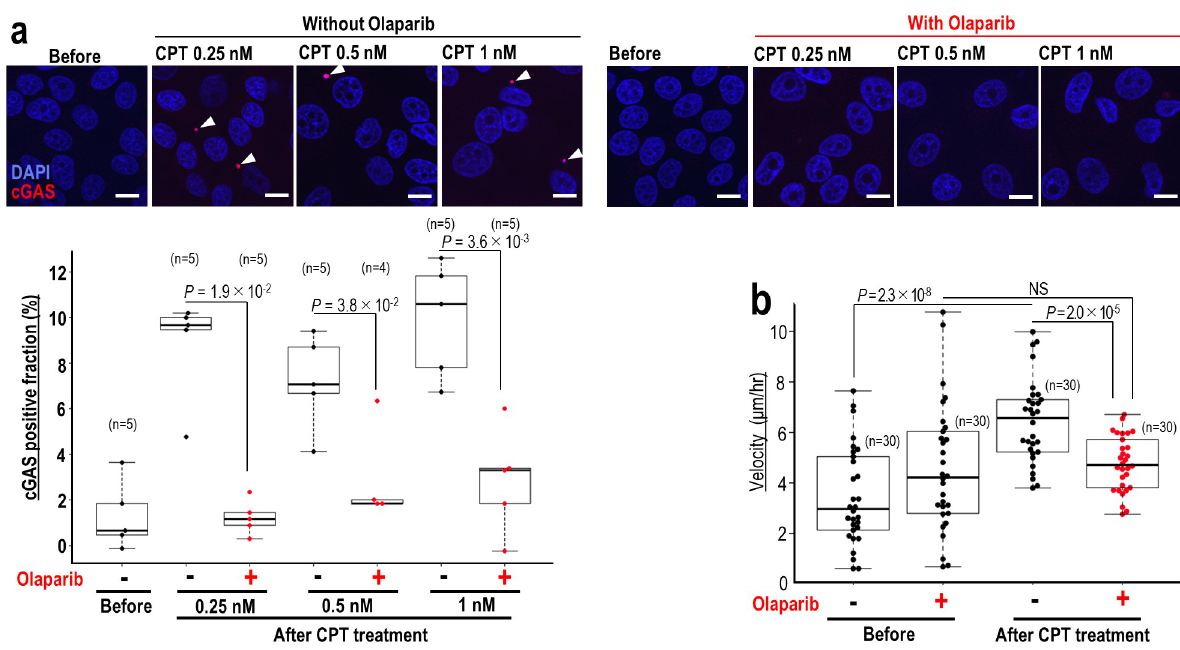
Fig 2. cGAS activation is suppressed by Olaparib, resulting in the suppression of cellular migration. ( a ) MCF7 cells treated with CPT were cultivated for 24 hr, and cGAS-positive cells were identified by immunofluorescence. ( b ) MCF7 cells were treated as in ( a ) with 0.5 nM CPT and monitored by time lapse imaging (n numbers are indicated on graph). Migration rates are shown as the velocity 24 to 48 hr post CPT treatment. Scale bars in images, 10 μ m. Bars show means ± s.d. Two-tailed Welch’s t-test was used for statistical analysis.